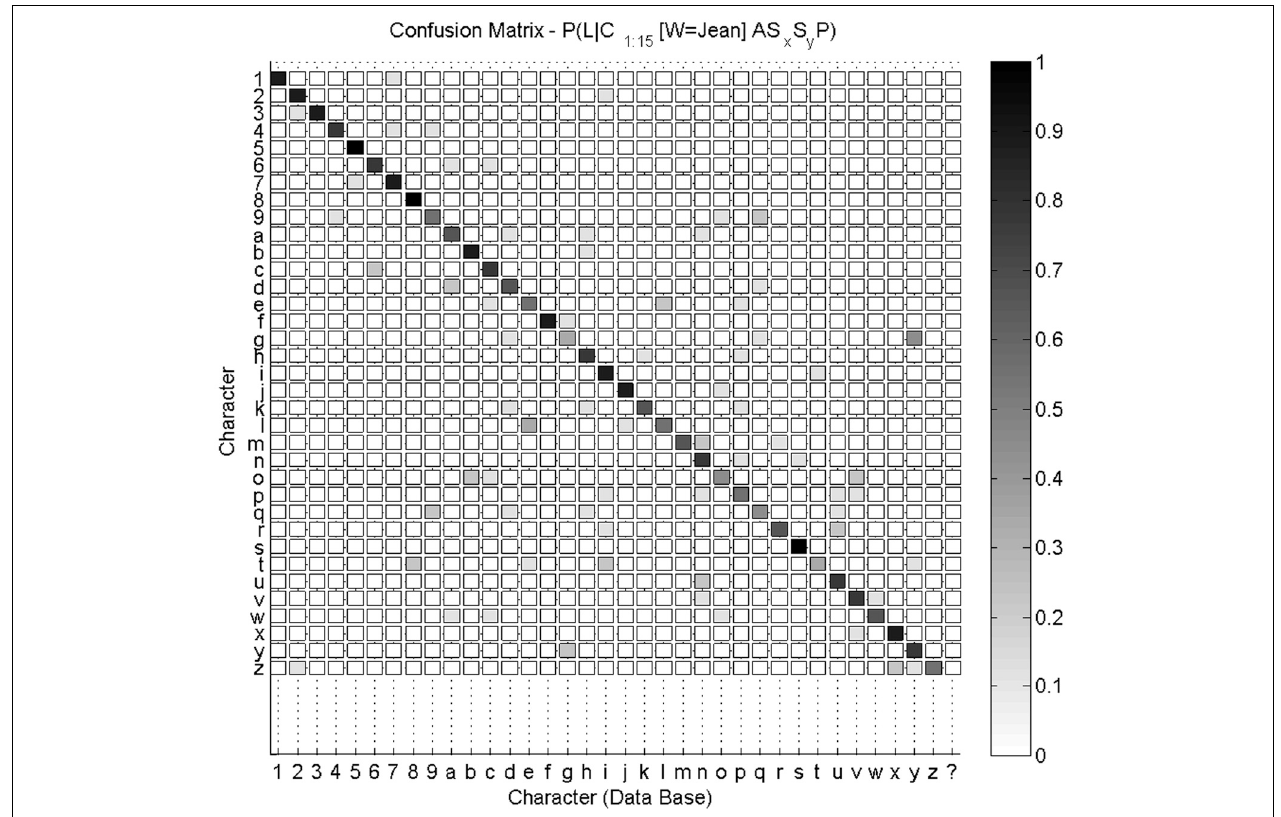
FIGURE 9 | Confusion matrix for character recognition. Each row is a frequency count of characters recognized by the system (e.g., row labeled “9” was shown previously Figure 8 ), with darker colors associated with